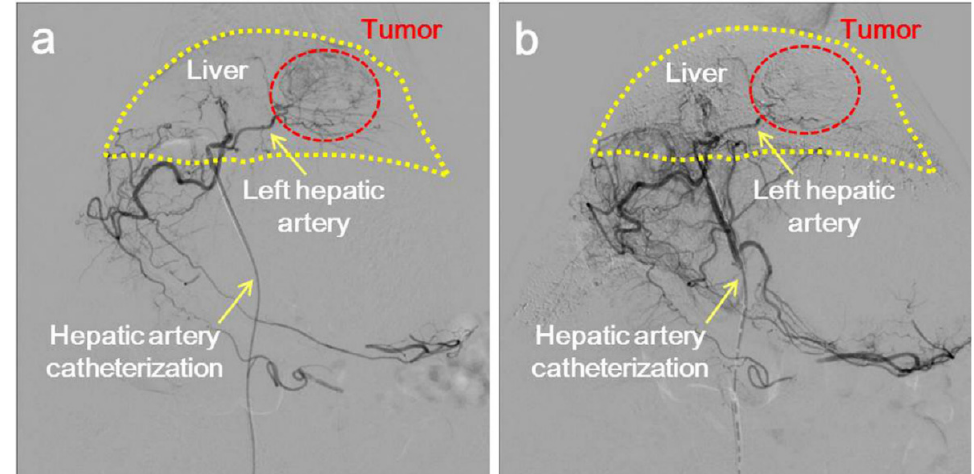
Figure 8. Integrated periodic mesoporous organosilicon loaded ferric oxide particles and doxorubicin for TACE treatment of liver cancer. ( a , b ) The comparison of particle induced TACE before and after treatment. The schematic diagram reveals the hepatic artery angiography with DSA guidance. Reprinted with permission from Ref. [88]. Copyright 2021 Elsevier Ltd.